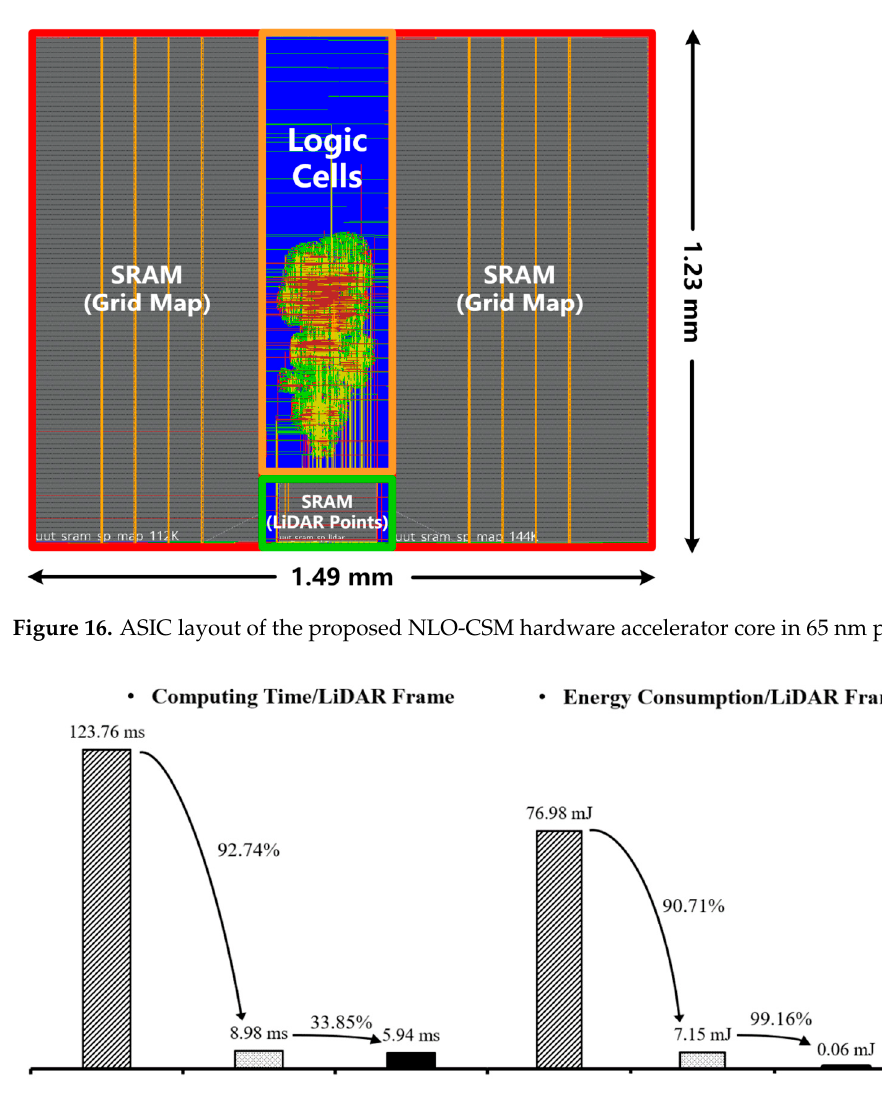
Figure 16. ASIC layout of the proposed NLO-CSM hardware accelerator core in 65 nm process.